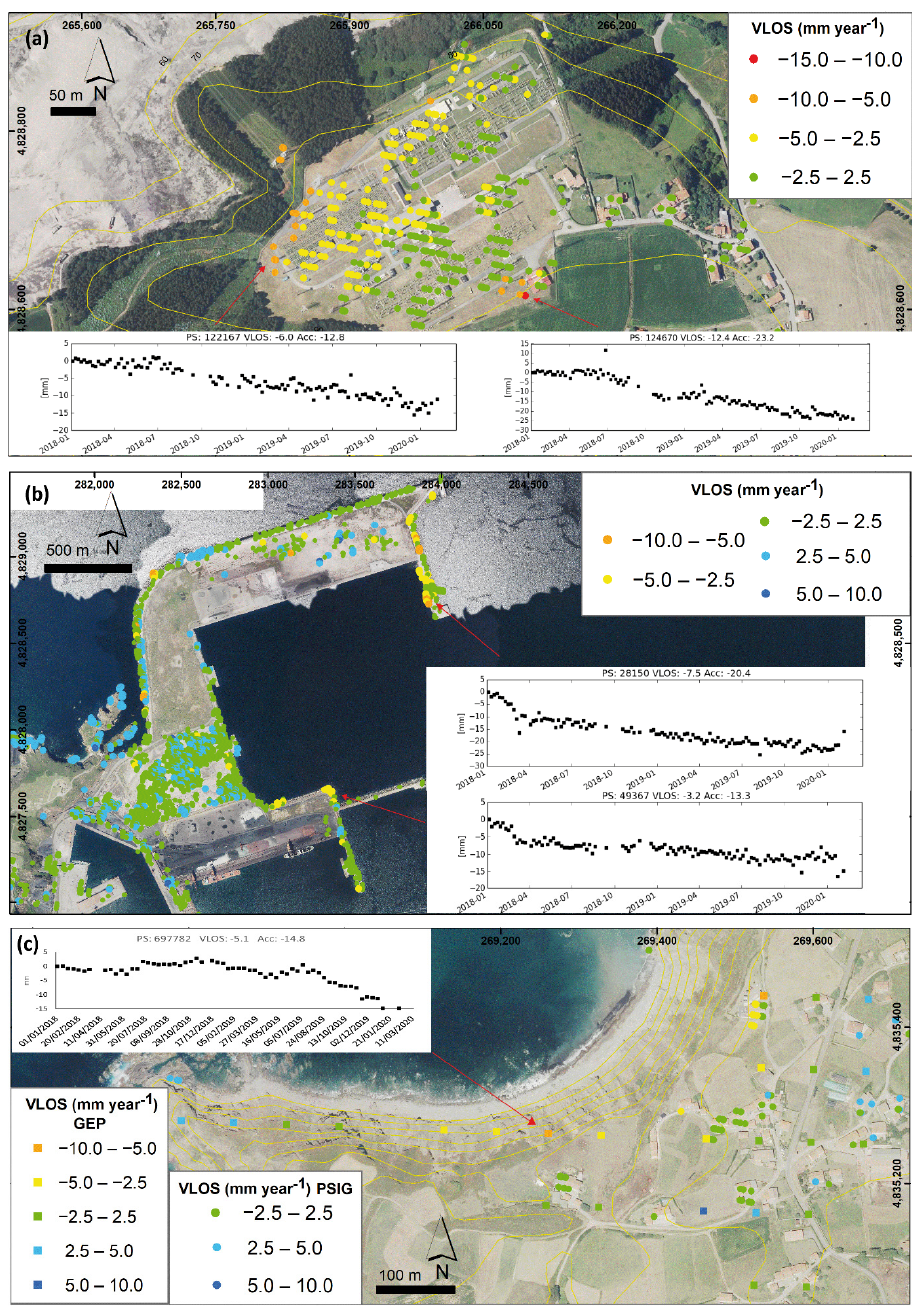
Figure 5. ( a ) Deformations detected in an electrical sub-station (Avilés city) through some observed time series obtained by PSIG software; ( b ) PSIG deformations measured in Musel Port (Gijón city) showing some representative time series; ( c ) GEP and PSIG PS detected in a cliff area. See locations in Figure 4. OrtoPNOA 2017 CC-BY 4.0 scne.es.